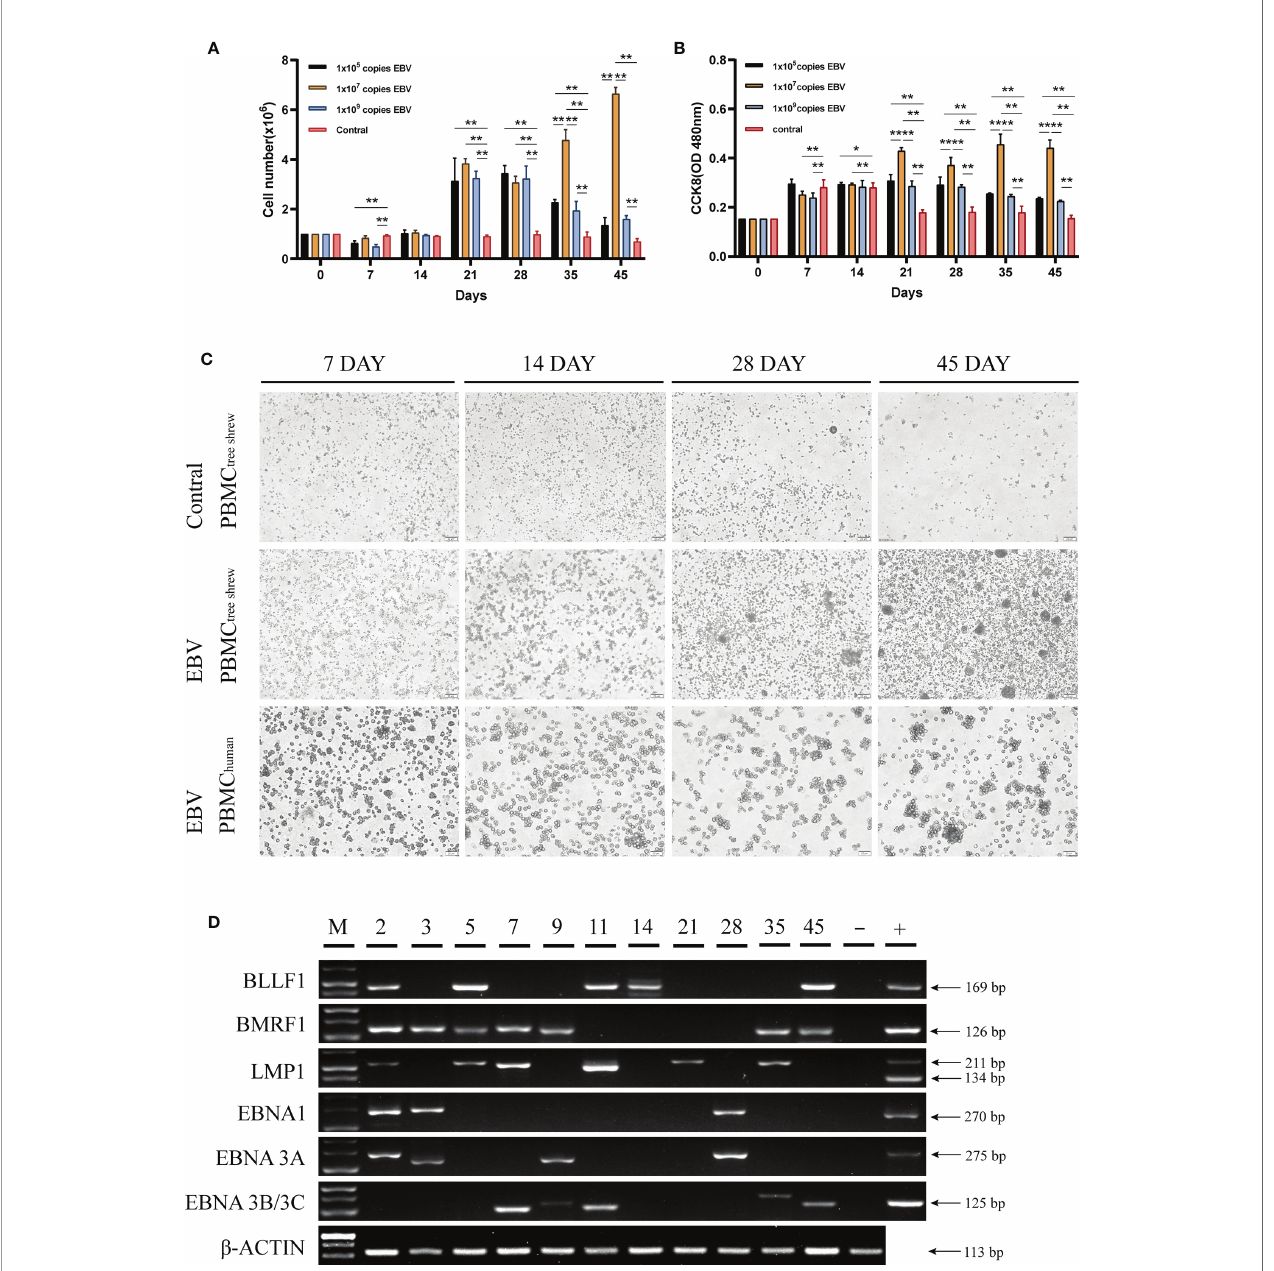
FIGURE 3 | Susceptibility of tree shrew primary cells to EBV infection. (A) Growth levels of PBMCs, measured by cell counting. (B) CCK8 assay assessment of the proliferation of PBMCs after treatment with different copy numbers of EBV. (C) Changes in PBMCs morphology of tree shrew and human, detected by light microscopy at 7 dpi, 14 dpi, 28dpi, 45 dpi after treatment with 1x10 7 copies EBV. Control cells were treated with an equal volume of 1640 medium. (D) Agarose gel electrophoresis of the EBV encoded genes from PBMCs treated with 1x10 7 copies EBV for 49 days by RT-PCR. *p<0.05,